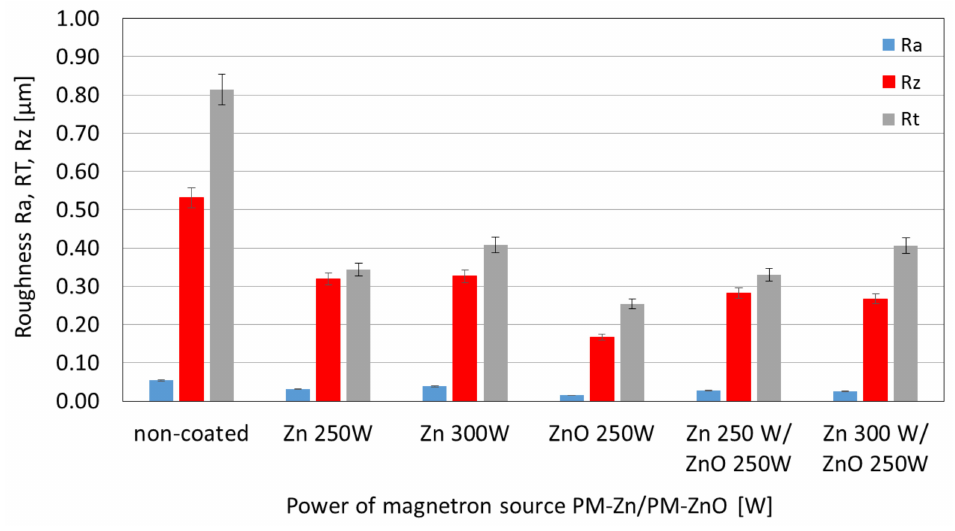
Figure 3. The comparison of the roughness for three types of coatings: one-component Zn and ZnO coatings and two-component Zn/ZnO coatings deposited by different magnetron power sources.